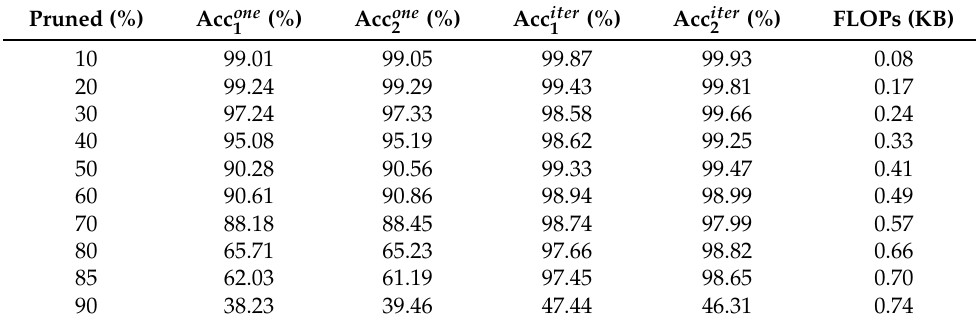
Table 5. Comparison results of iterative pruning and one-shot pruning: Layer-wise pruning per- formance of the model with 10 hidden neurons. Acc one (%) means the accuracy after removing the 1 redundancy in W xh and W hh by one-shot pruning; then Acc one (%) is after removing less important 2 connections in W ho . Similarly, Acc iter (%) denotes the results adopting the iterative method. Pruned (%) Acc one (%) Acc one 1